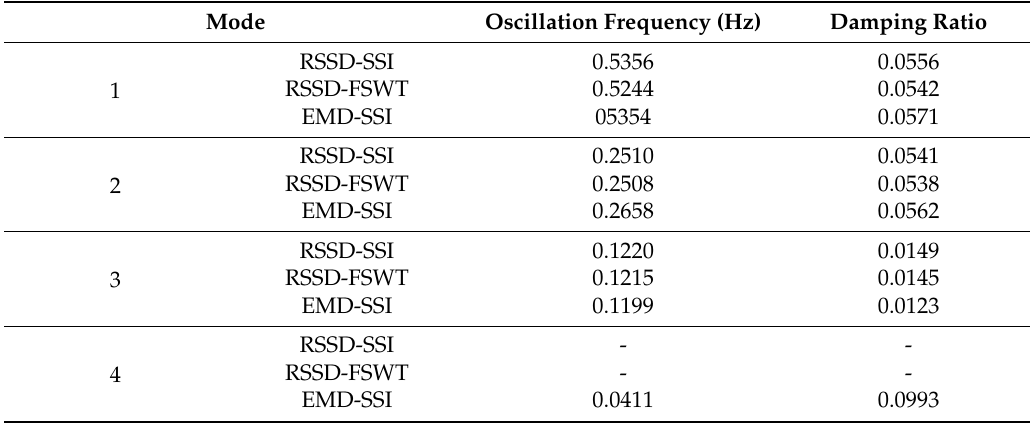
Table 5. Parameters of low frequency oscillation